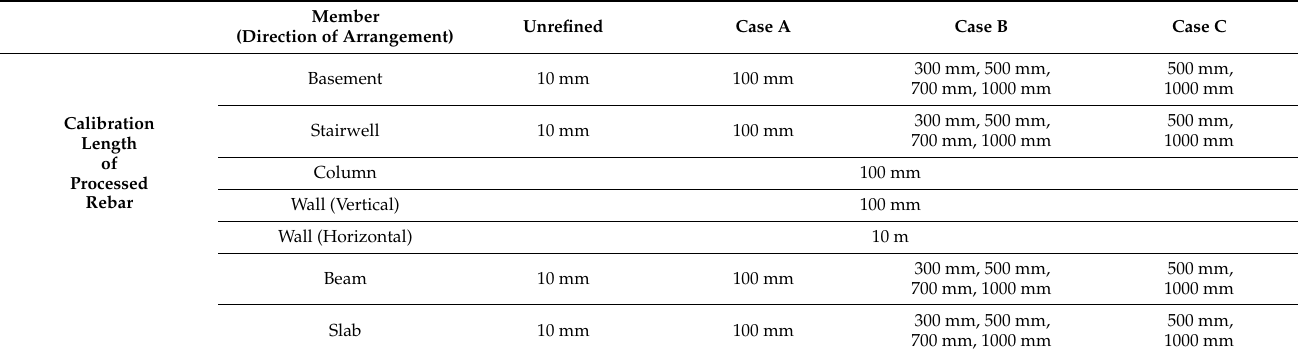
Table 2. Calibration Lengths of Processed Rebar by